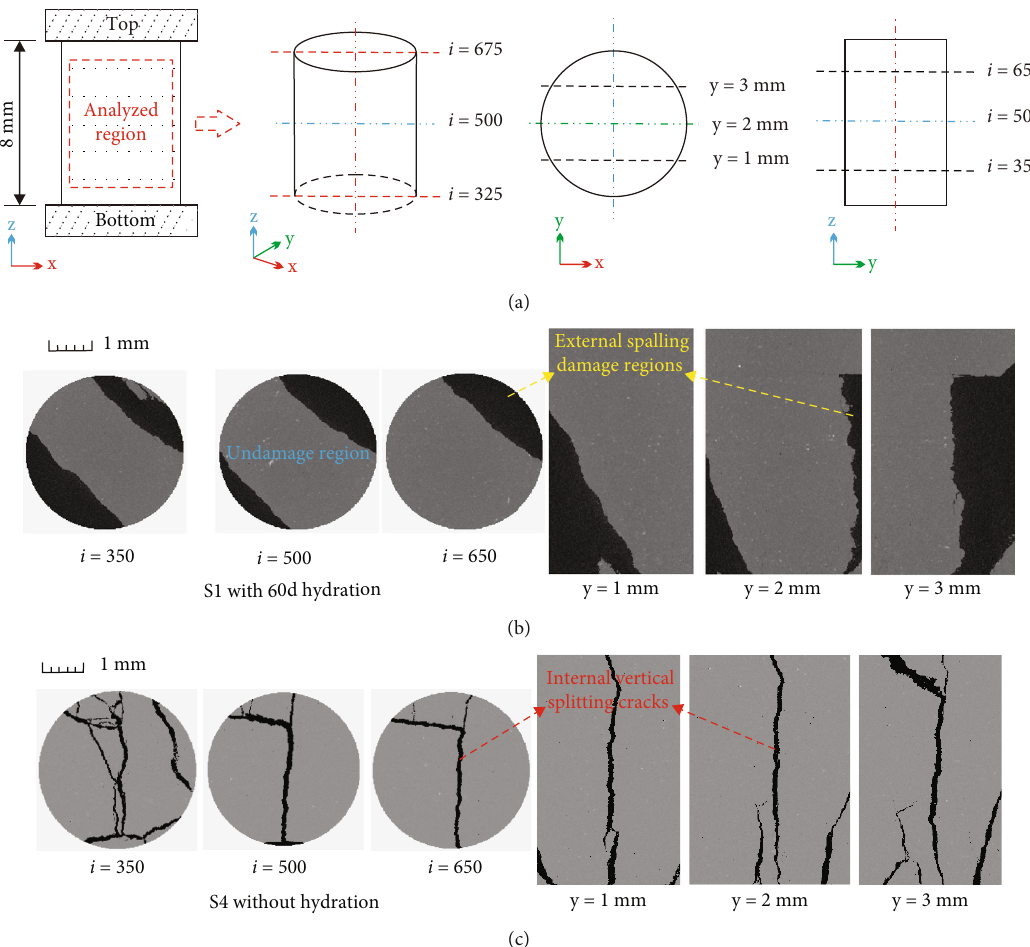
Figure 6: CT slice position (a) and results of failure S1 with 60d hydration (b) and S4 without hydration